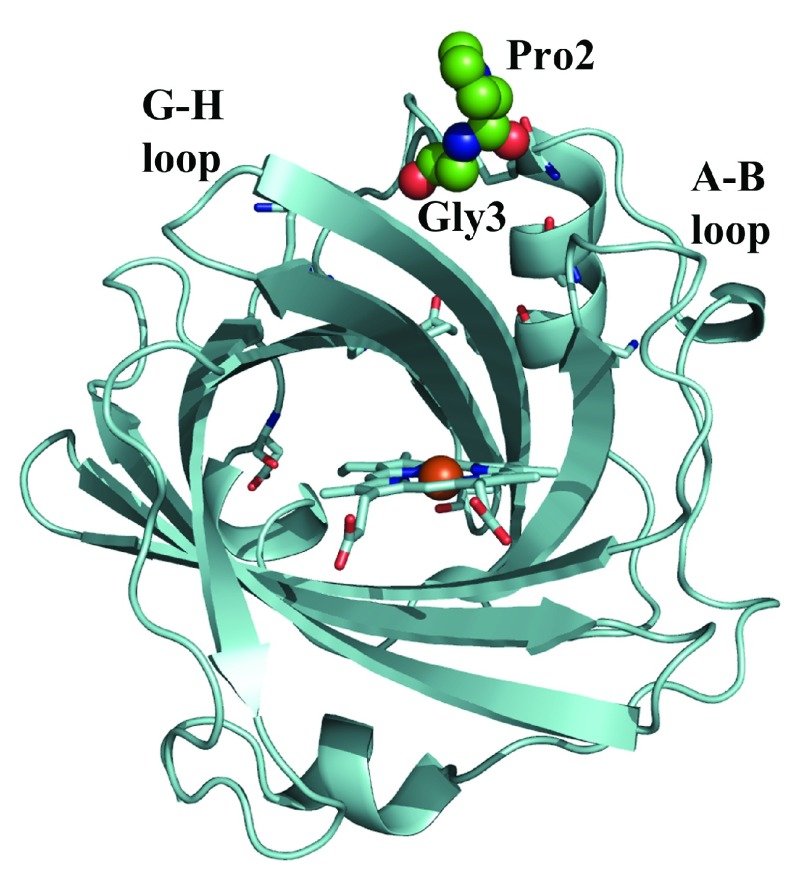
Representation of the backbone in the X-ray structure of NP7 solved at low pH (5.8).Residues Pro and Gly of the extra N-terminus stretch (Leu-Pro-Gly) found in NP7 are shown as green-coloured spheres. The spatial position of Leu, and the additional Met0 residue originating from the start codon of the expression system, were not seen in the X-ray crystal.